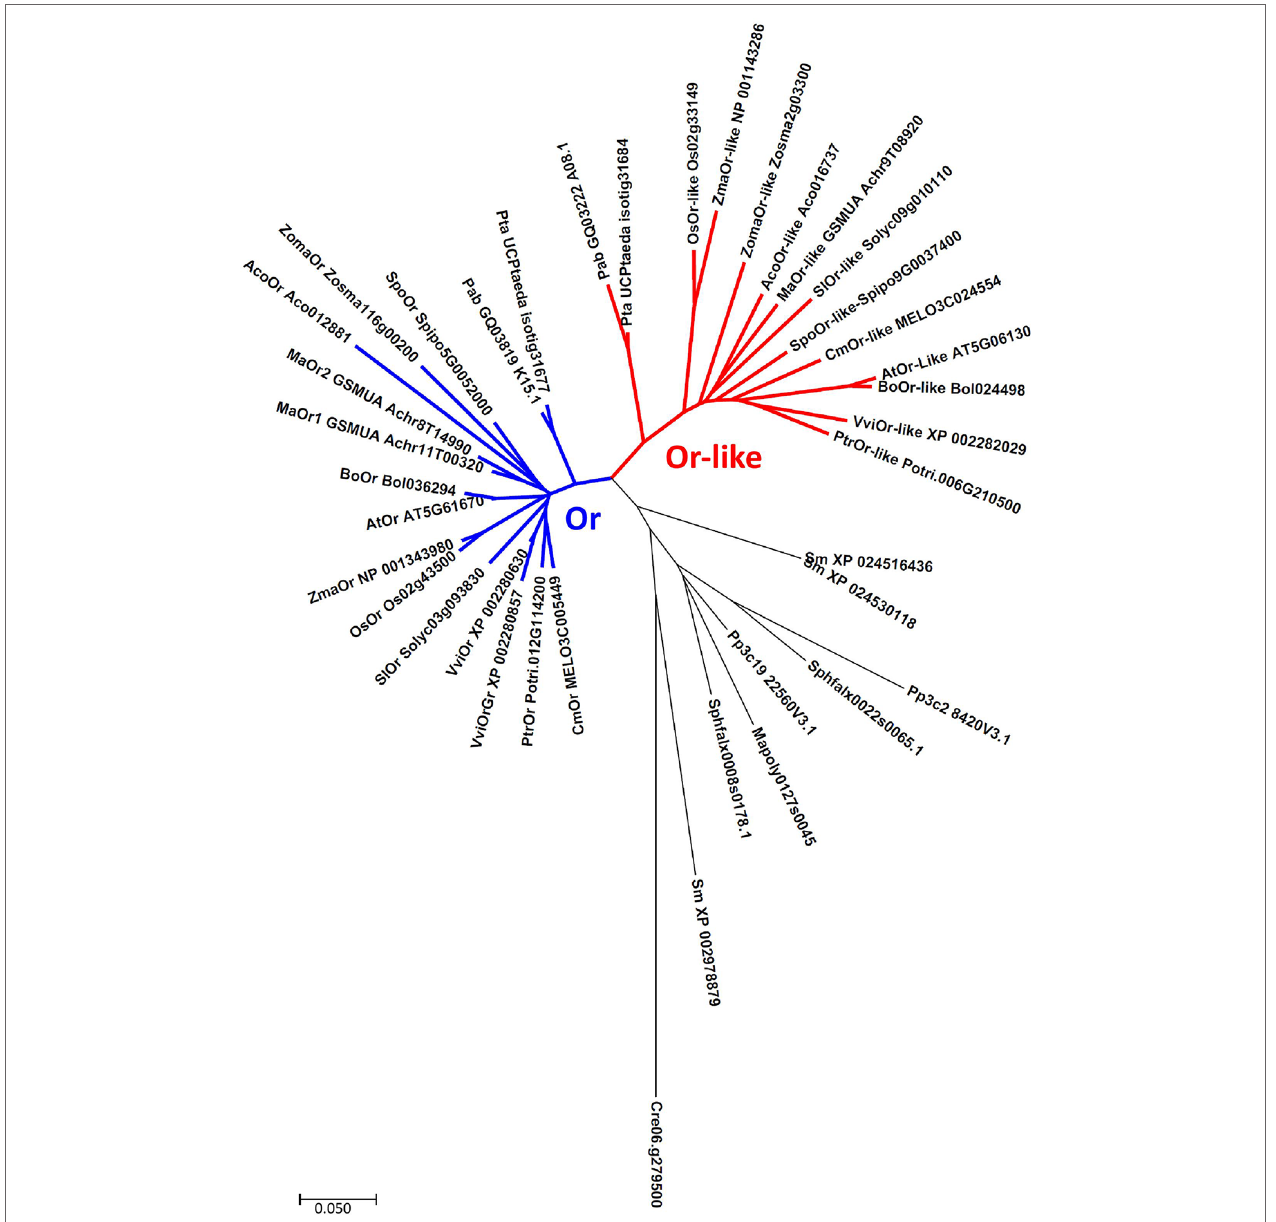
FIGURE 1 | Neighbor-joining phylogenetic tree of OR and OR-like proteins. Cluster analysis associate’s gene duplication with bryophytes and exhibits two distinctively separate clades, conserved from gymnosperms onwards. Abbreviations- Algae: Cre ( Chlamydomonas reinhardtii ). Liverworts: Mapoly ( Marchantia polymorpha ). Mosses: Pp ( Physcomitrella patens ), Sphfalx ( Sphagnum fallax ). Lycophytes: Sm ( Selaginella moellendorffii ). Gymnosperms: Pte ( Pinus taeda ), Pab ( Picea abies ). Angiosperms: Aco ( Ananas comosus ), Ma ( Musa acuminata ), Spo ( Spirodela polyrhiza ), Zoma ( Zostera marina ), Os ( Oryza sativa ), Zma ( Zea mays ), Sl ( Solanum lycopersicum ), Vvi ( Vitis vinifera ), Ptr ( Populus trichocarpa ), At ( Arabidopsis thaliana ), Bo ( Brassica oleracea ), Cm ( Cucumis melo ). Sequences were downloaded from Phytozome (http://www.phytozome.net), National Center for Biotechnology Information (http://www.ncbi.nlm.nih.gov), TAIR (https://www.arabidopsis.org), Sol Genomics Network (https://solgenomics.net), CuGenDB (http://cucurbitgenomics.org), and ConGenIE (http://congenie.org). Created with MEGA 7 (Kumar et al.,